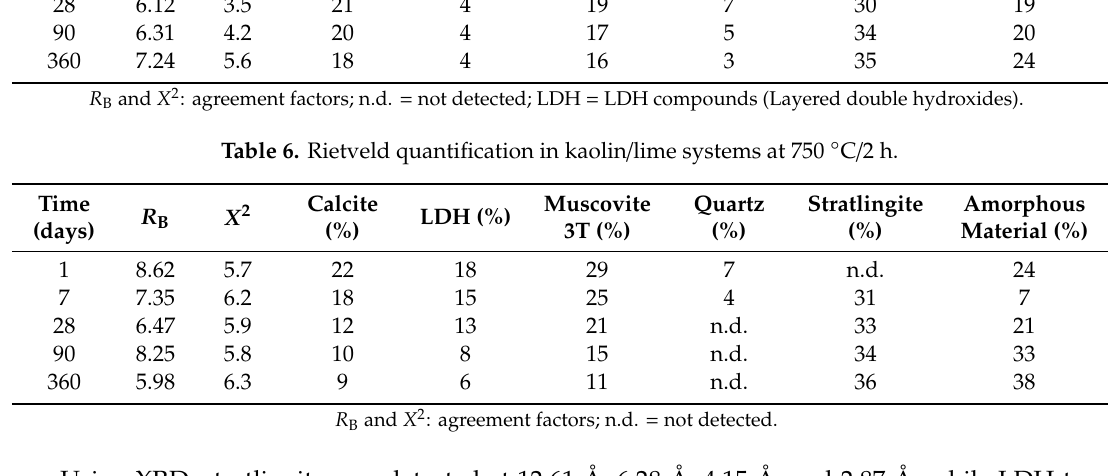
Figure 5. Fixed lime evolution with different activation conditions. The fixed lime values for the samples calcined at both temperatures show high pozzolanic activity at all reaction times. These results correspond to a logarithmic growth up to 90 days, in which time the maximum is practically reached. This situation is comparable for all the activation conditions and for longer times.